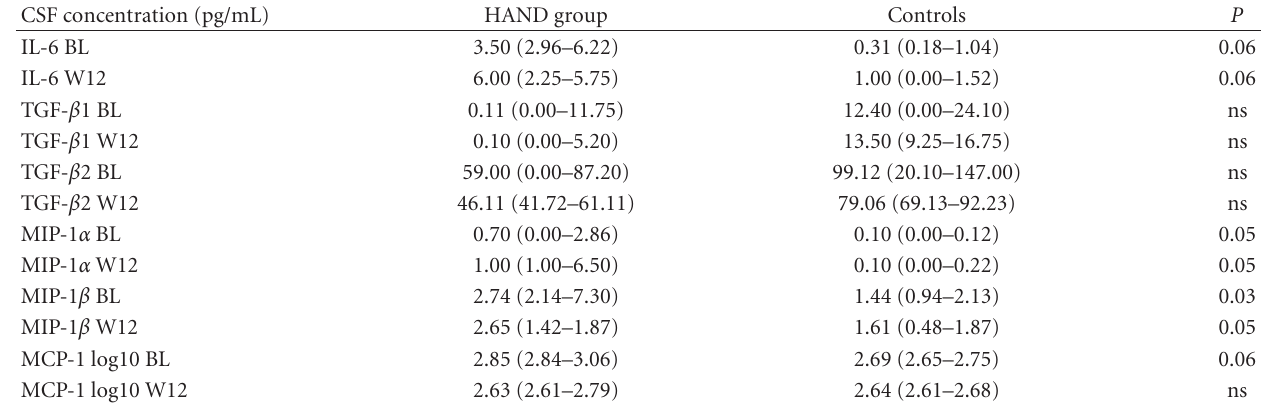
Table 2: CSF inflammation markers